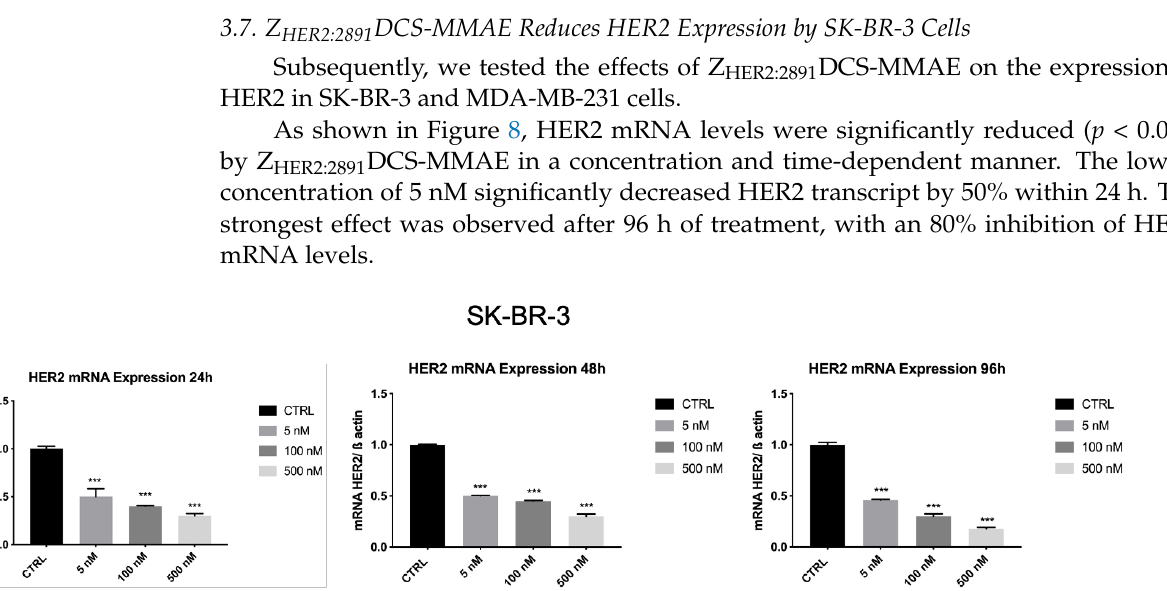
Figure 7. Detection of cell death induced by Z HER2:2891 DCS-MMAE and trastuzumab treatments. The effect of cellular death induced by Z HER2:2891 DCS-MMAE and trastuzumab was tested in SK-BR-3 ( A , C ) and MDA-MB-231 cells ( B ) by flow cytometry. The top left quadrant represents the percentage of early apoptotic cells (Annexin V + /PI − ), the top right quadrant is the percentage of late apoptotic cells (Annexin V + /PI + ); whereas the bottom left quadrant represents the percentage of live cells (Annexin V − /PI − ) and the bottom right quadrant represents the percentage of necrotic cells (Annexin V + /PI + ). Cells were treated with the substances for 10 min followed by drug removal and an additional 48 h of incubation in medium alone (black bar) or for 48 h of continuous exposure to treatments (blue bar). The p -value was determined by one-way ANOVA test with Dunnett post hoc test and considered significant for p < 0.05 *, p < 0.001 *** compared to the control. Data are presented as mean ± SEM.